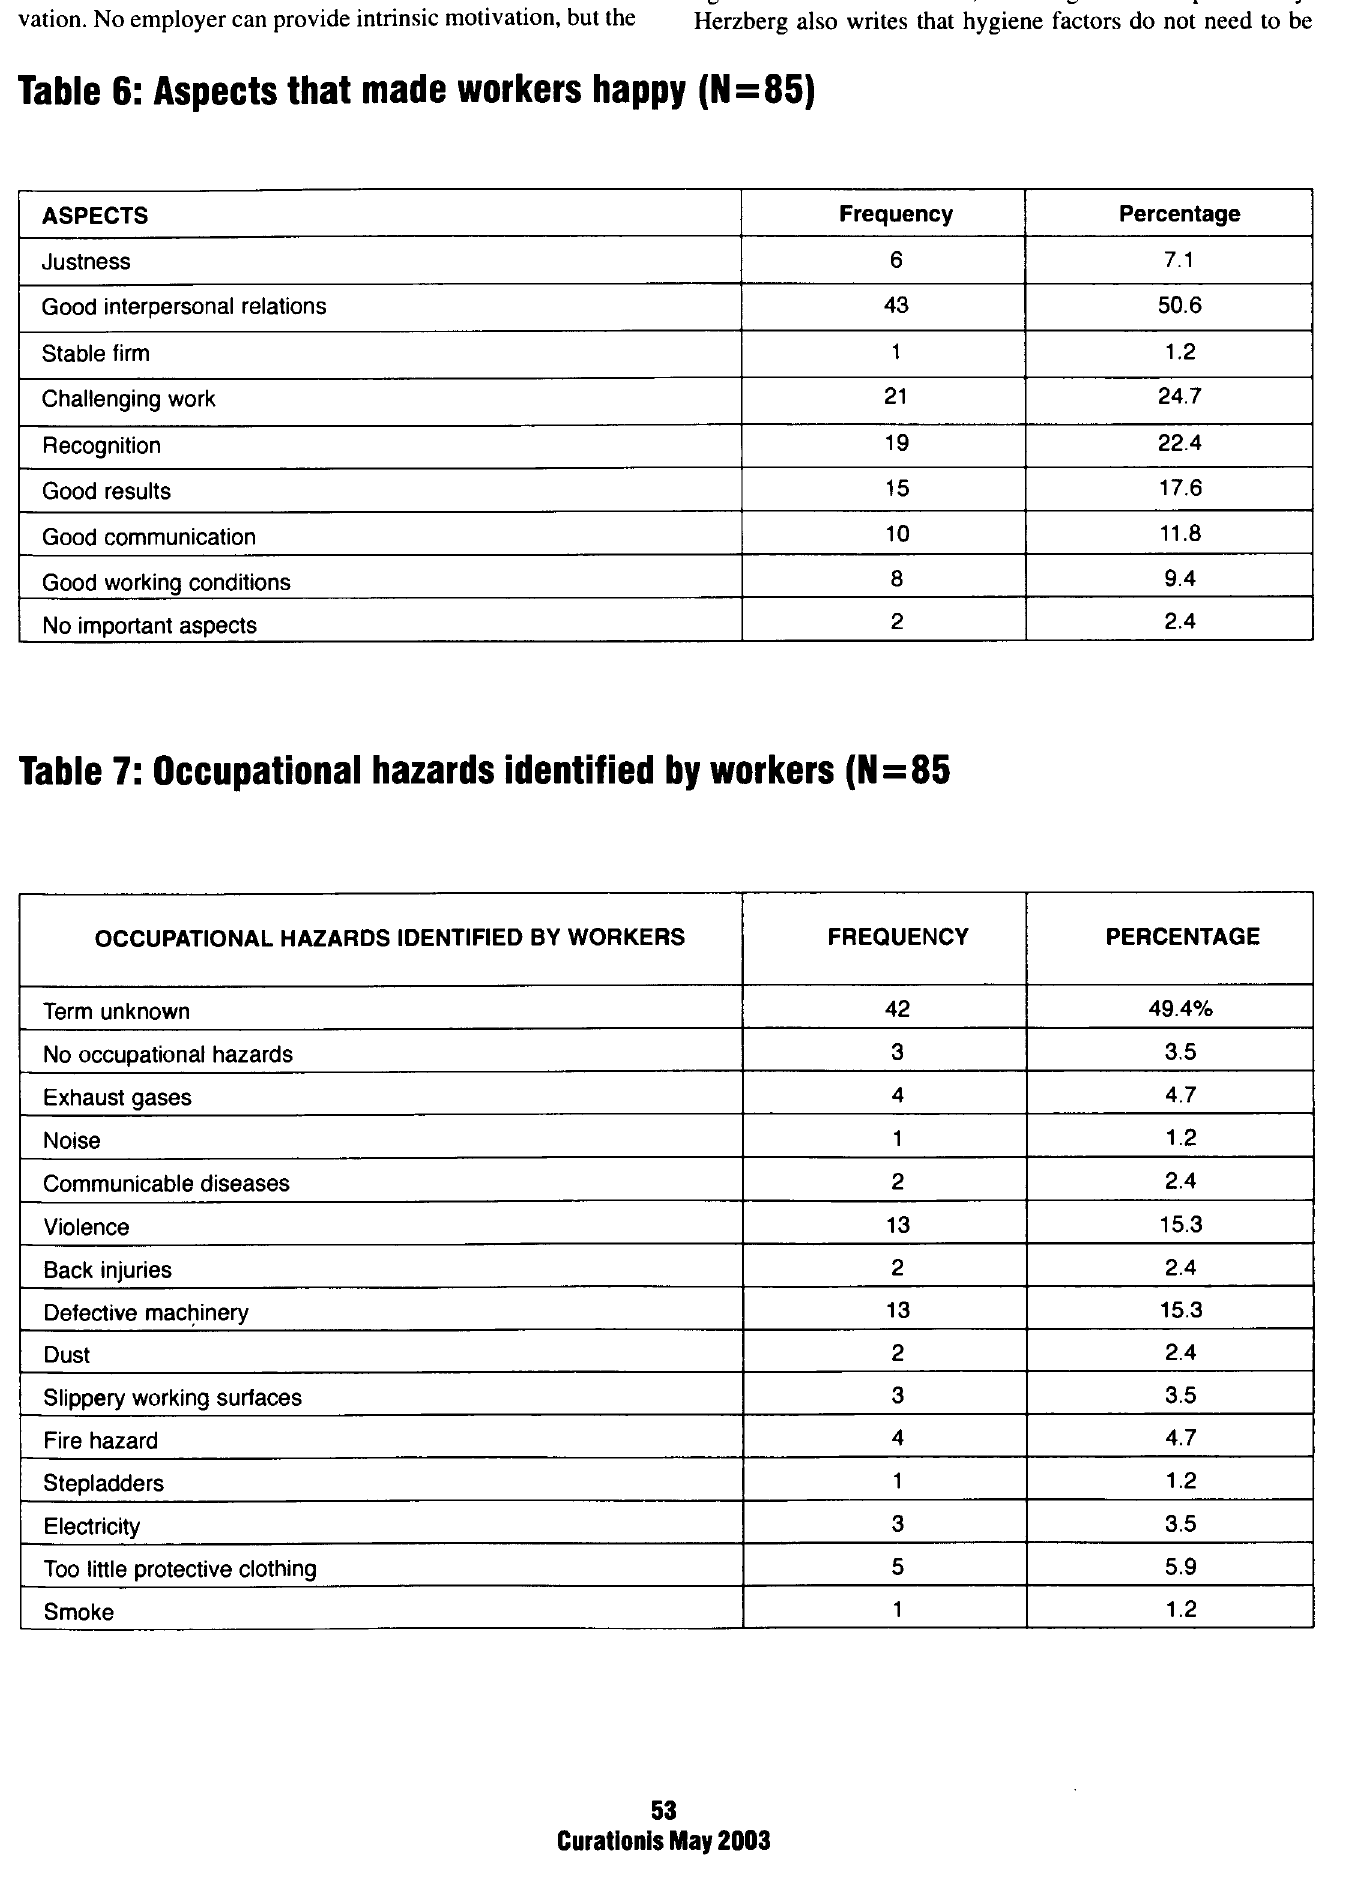
Table 7: Occupational hazards Identified by workers (N=85